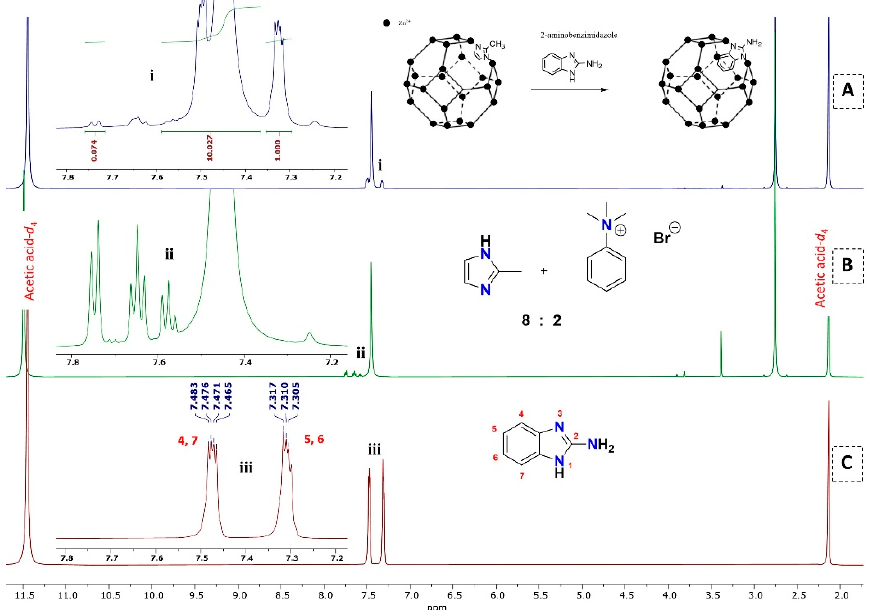
Figure 12. 1 H NMR spectra (in CD 3 COOD) of (A) exchanged ZIF-8 sample by 2-NH 2 bZIM (1:3), (B) ZIF-8 and (C) 2-aminobenzimidazole.